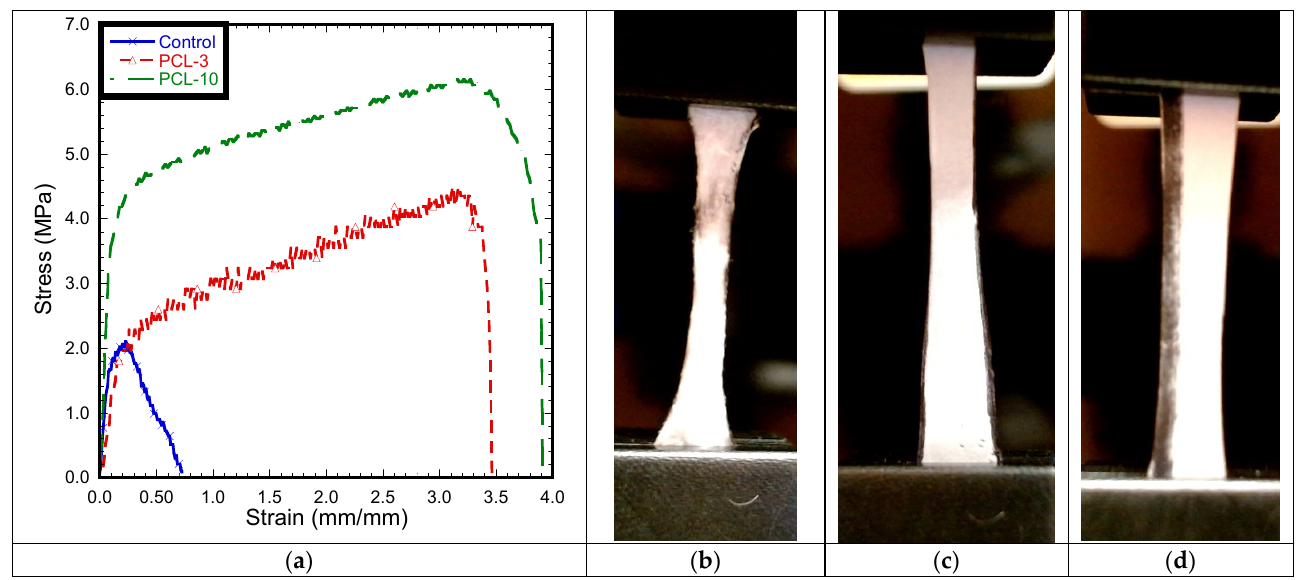
Figure 12. ( a ) Stress–strain curve of pull-out tension tests for ( b ) control, ( c ) PCL-3, and ( d ) PCL-10 cloths.